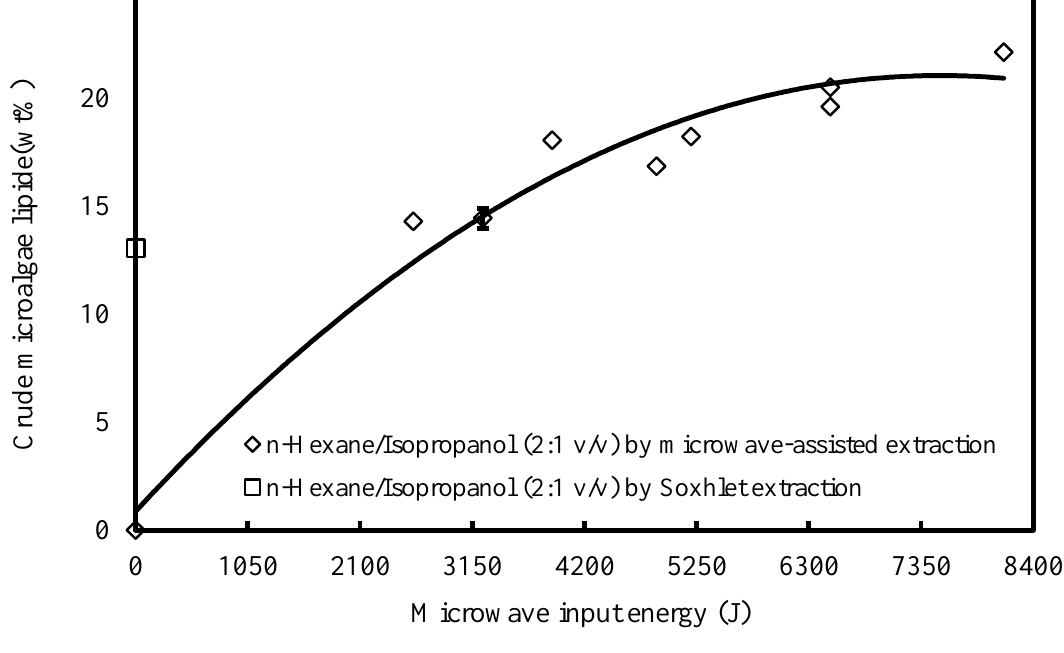
Figure 5. Comparison of the crude microalgae lipid quantities extracted using the Soxhlet and microwave-assisted extraction methods with an n -hexane and isopropanol solvent mixture under various input